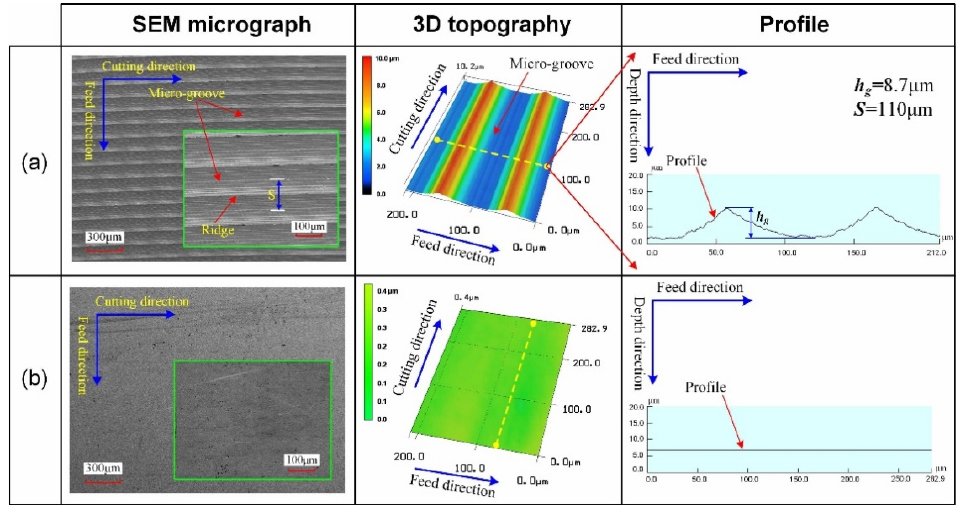
Figure 5. Surface topography of micro-grooved surface and polished surface: ( a ) surface #5; ( b ) sur- face #6.